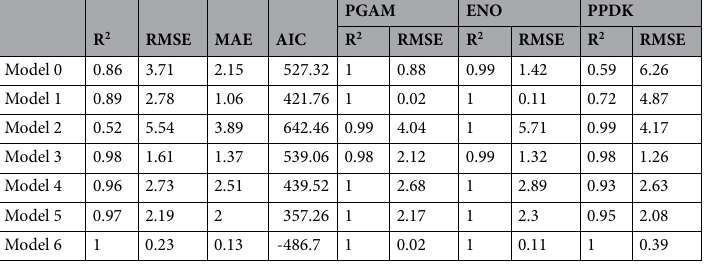
Table 7. Comparative table of statistical metrics of each model for the test set (Table